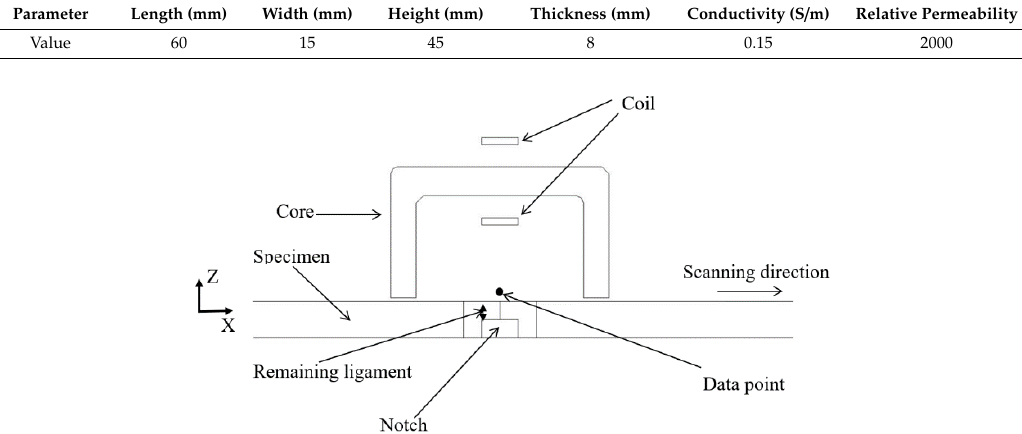
Figure 1. Finite element model of pulsed eddy current technique (PECT).